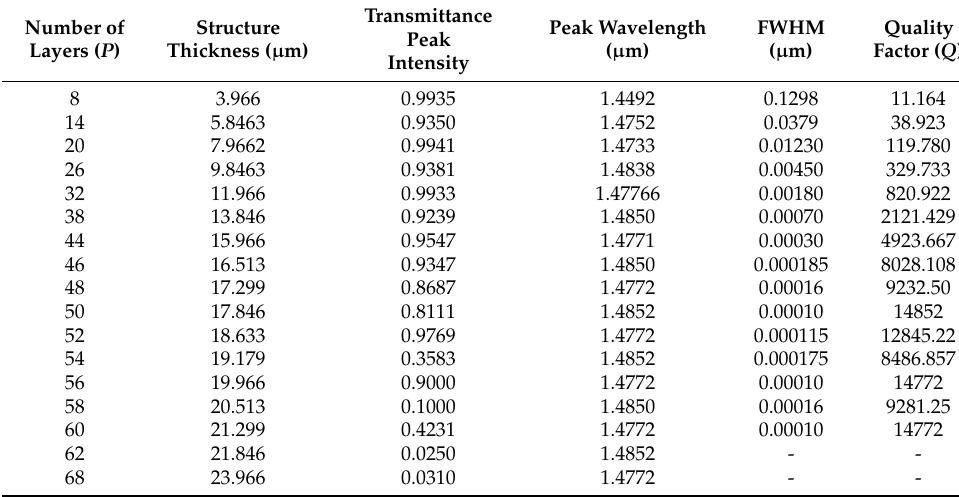
Figure 2. Transmittance spectrum for a periodic photonic structure with 36 alternated layers of fused silica and TiO 2 and with a middle cavity filled by seawater with 50% salinity and at room temperature. Table 1. Variation of the Peak Intensity, Peak Wavelength, Peak FWHM and the Q -factor for Different Values of P